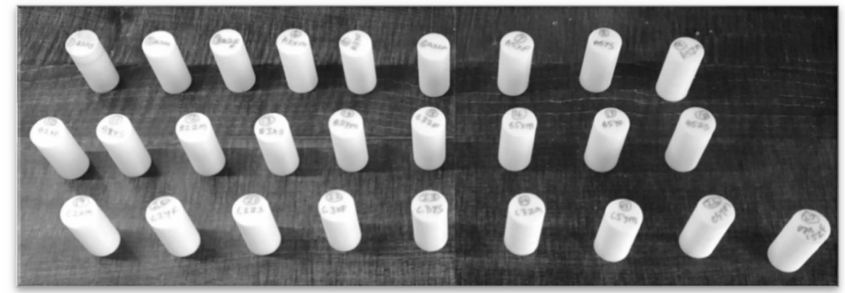
Figure 2. 3D printed fused deposition modelling parts.